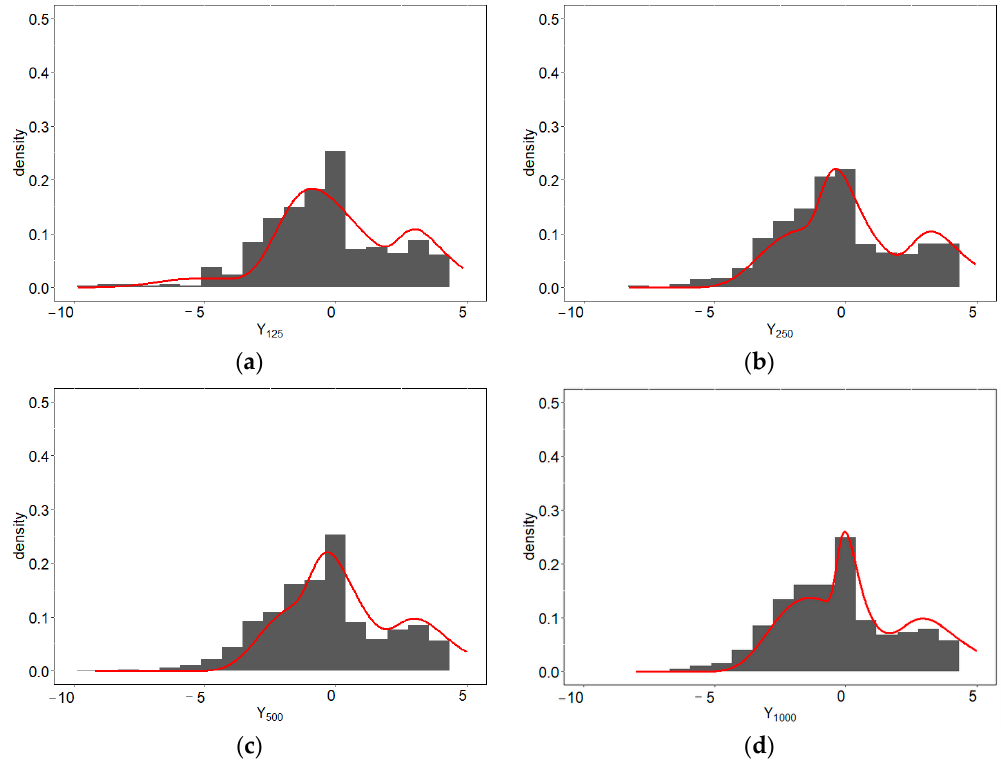
Figure 3. Histograms and predictive densities for the three-component EV-I mixture distribution with ( a ) 125, ( b ) 250, ( c ) 500, and ( d ) 1000 samples per component.